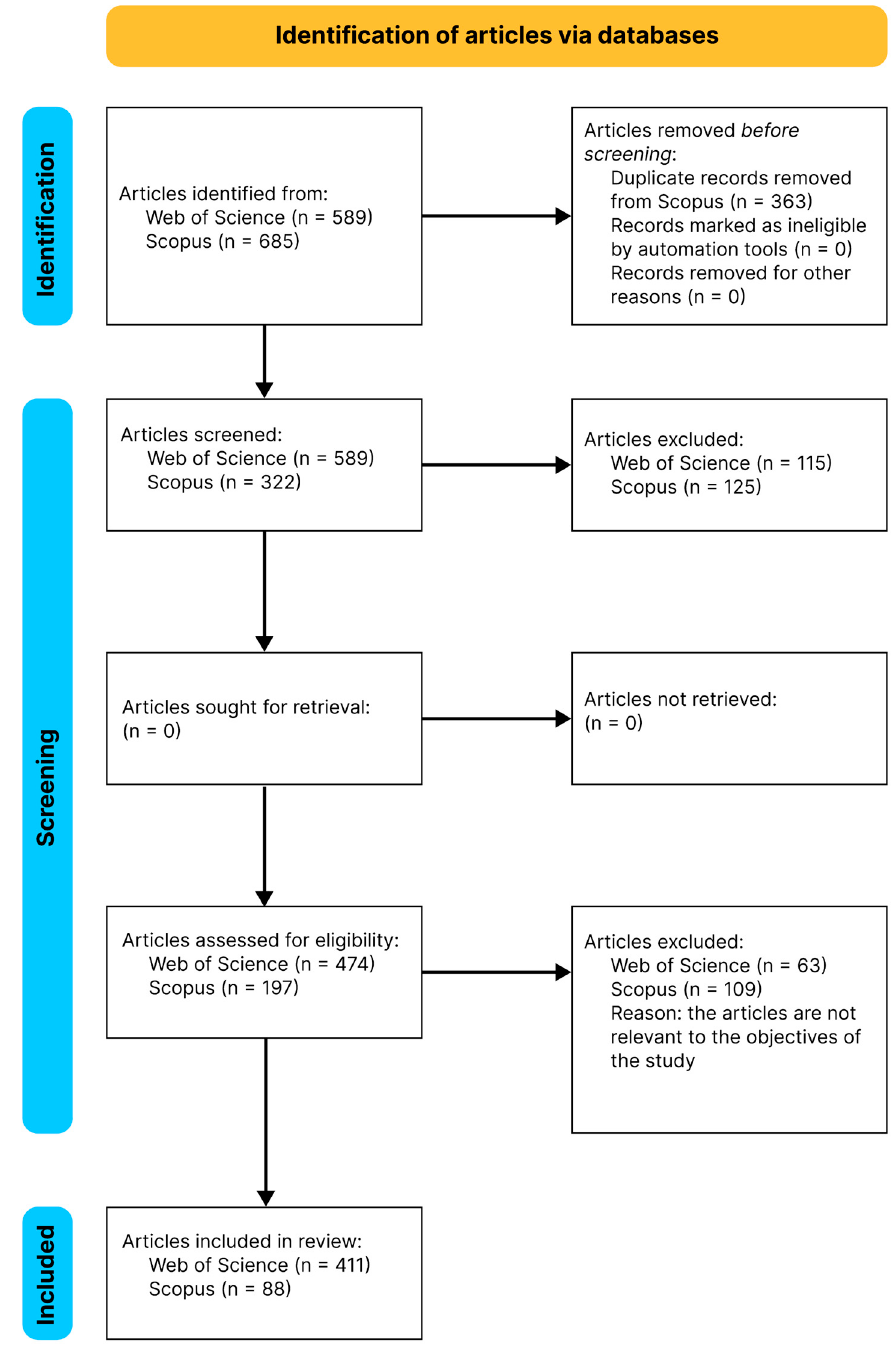
Figure 4. The main stages of the systematic review of the literature (according to PRISMA 2020 flow diagram for new systematic reviews, including searches in databases).